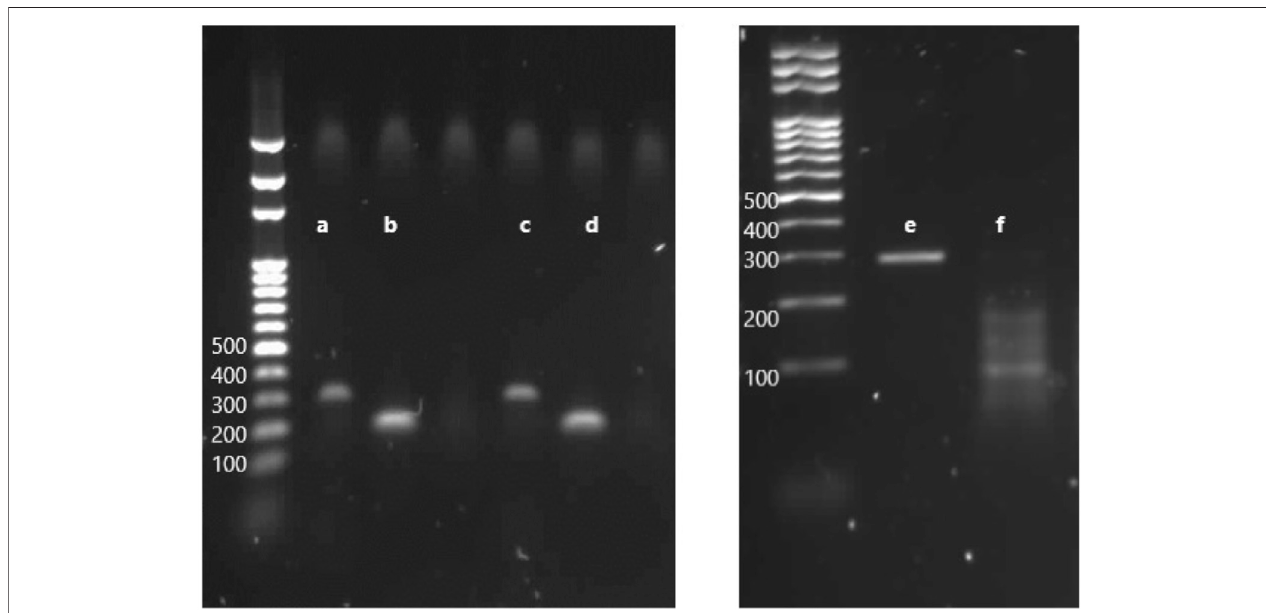
FIGURE 7 | Electrophoresis through an agarose gel to evaluate the in vitro ef fi ciency of cleavage by RNP complex on targeted loci . (A) PCR product with the primers HP2.5-1, amplicon length 315 bp. (B) PCR product with the primers HP2.5-2, amplicon length 201 bp. (C) PCR product with HP2.5-1 primers incubated with Cas9 and sgRNA1. (D) PCR product with HP2.5-2 primers incubated with Cas9 and sgRNA2. (E) PCR product of the targeted gene with a couple of primers HP2.5-3, amplicon length 296 bp. (F) PCR product of HP2.5-3 primers incubated with Cas9 and sgRNA3, cleaved fragments of the gene, two products — one of ~188 bp and one of ~108 bp — corresponding to the size fragments after DSB on the PAM sequence.